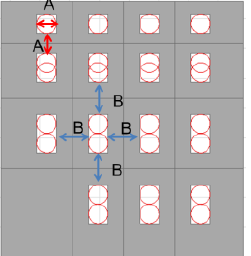
Figure 3. Testing classical proportions using orthographic imagery from surveyed classical buildings.